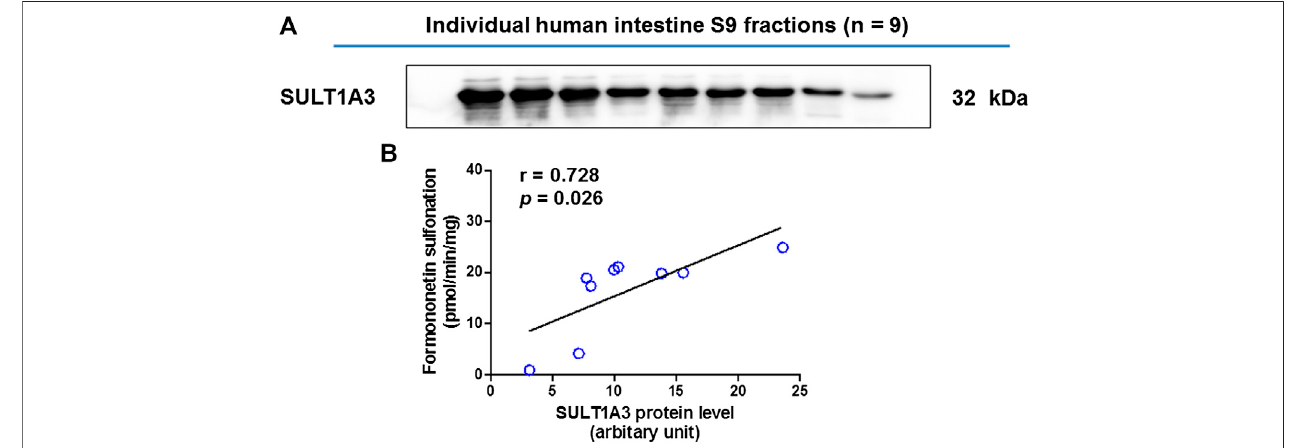
FIGURE 5 | (A) Enzyme kinetic pro fi le and Eadie-Hofstee plot (insert) of formononetin sulfonation in rSULT1A3. (B) Enzyme kinetic pro fi le and Eadie-Hofstee plot (insert) of formononetin sulfonation in HEK-SULT1A3 cell lysate. (C) Kinetic parameters derived for formononetin sulfonation in rSULT1A3 enzyme and HEK-SULT1A3 cells lysate. Each data point was shown as mean ± SD (n (cid:1) 3). *** p < 0.001 compared with cell lysate.